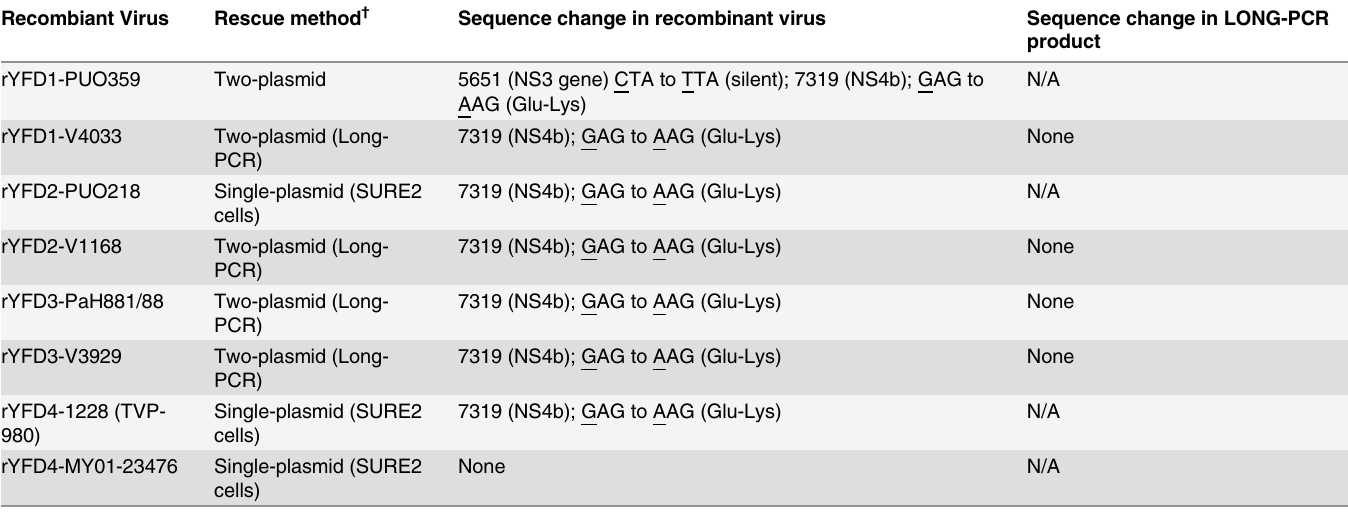
Table 2. Summary of recombinant viruses recovered. Recombiant